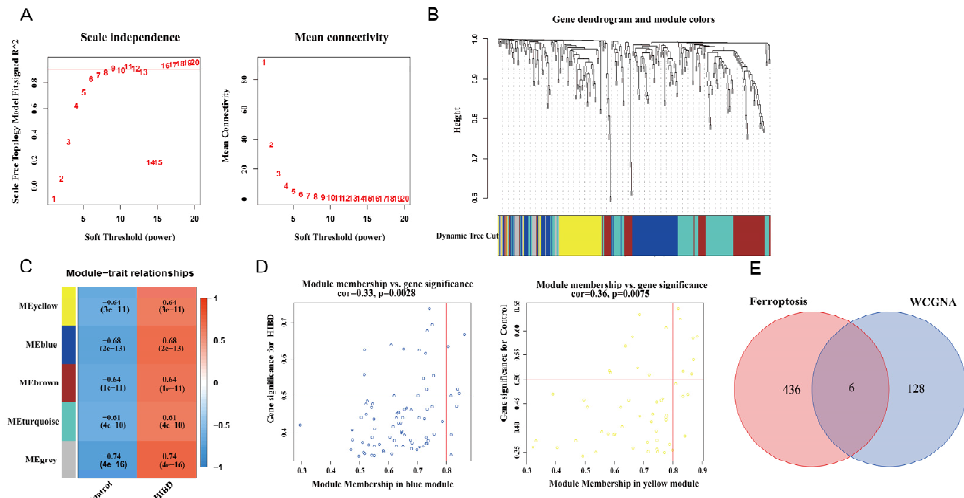
Figure 2. Weighted co-expression network analysis. ( A ) Assessment of scale-free fit index (left) and mean connectivity (right) for distinct soft threshold powers. ( B ) Dendrogram of clustering of differentially expressed genes based on topological overlap matrix. ( C ) Heatmap of the correlation between modules and sample traits. ( D ) Two scatter plots of gene significance for HIBD vs. module membership in the blue module and yellow module. ( E ) Venn plot for intersected genes in WGCNA modules and ferroptosis-related genes.